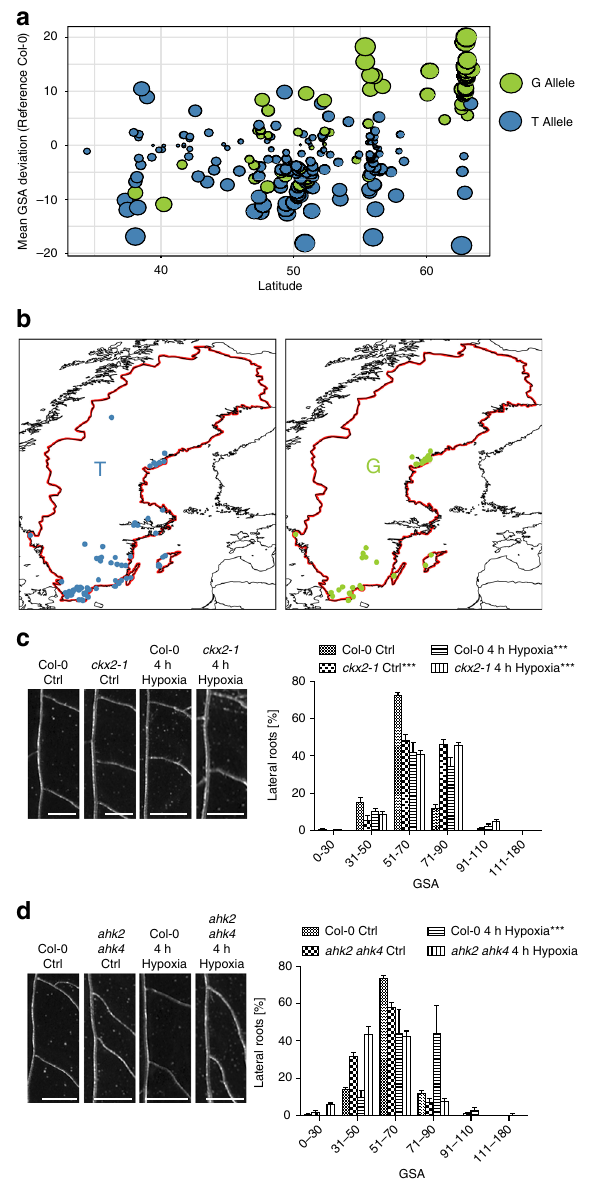
Fig. 4 Cytokinin signaling integrates environmental signals into angular lateral root growth. a Comparison of the mean GSA distribution and its geographical (latitude) distribution of the phenotyped accessions. T and G allele of CKX2 are depicted in blue and green, respectively. b Relative geographical distribution of the T and G allele of CKX2 in all sequenced Swedish Arabidopsis accessions. The distribution of accessions is visualized by R package “ rworldmap ” . c , d Representative images and GSA distributions of c Col-0 wild-type and ckx2-1 or d Col-0 wild type and ahk2 ahk4 with and without hypoxia treatment for 4 h. Scale bars, 2